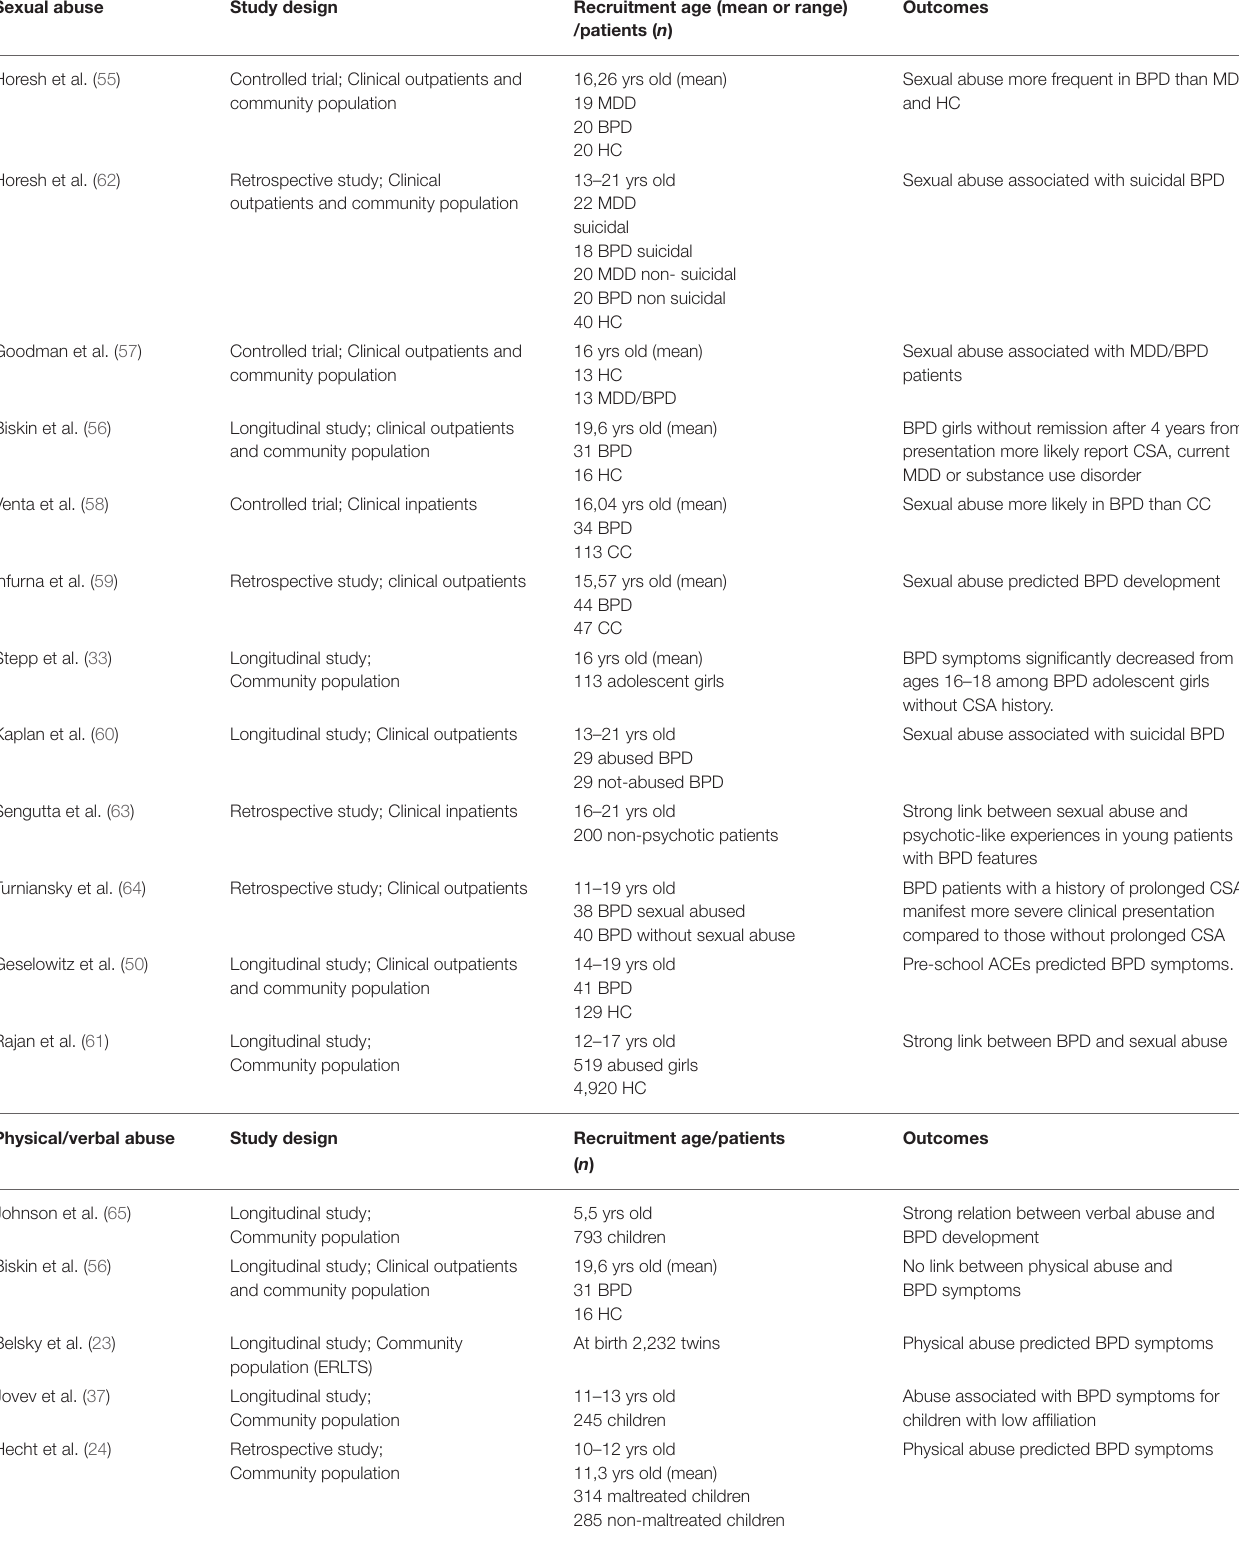
TABLE 2 | Studies on precocious traumas (sexual abuse, physical/verbal abuse, neglect, and bullying) and early onset BPD. Sexual